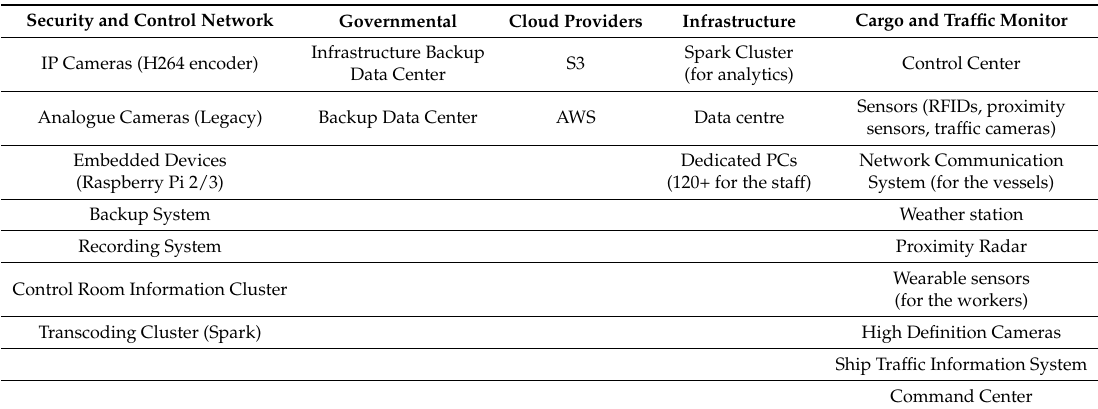
Figure 17. Port Architecture. Table 1. Available